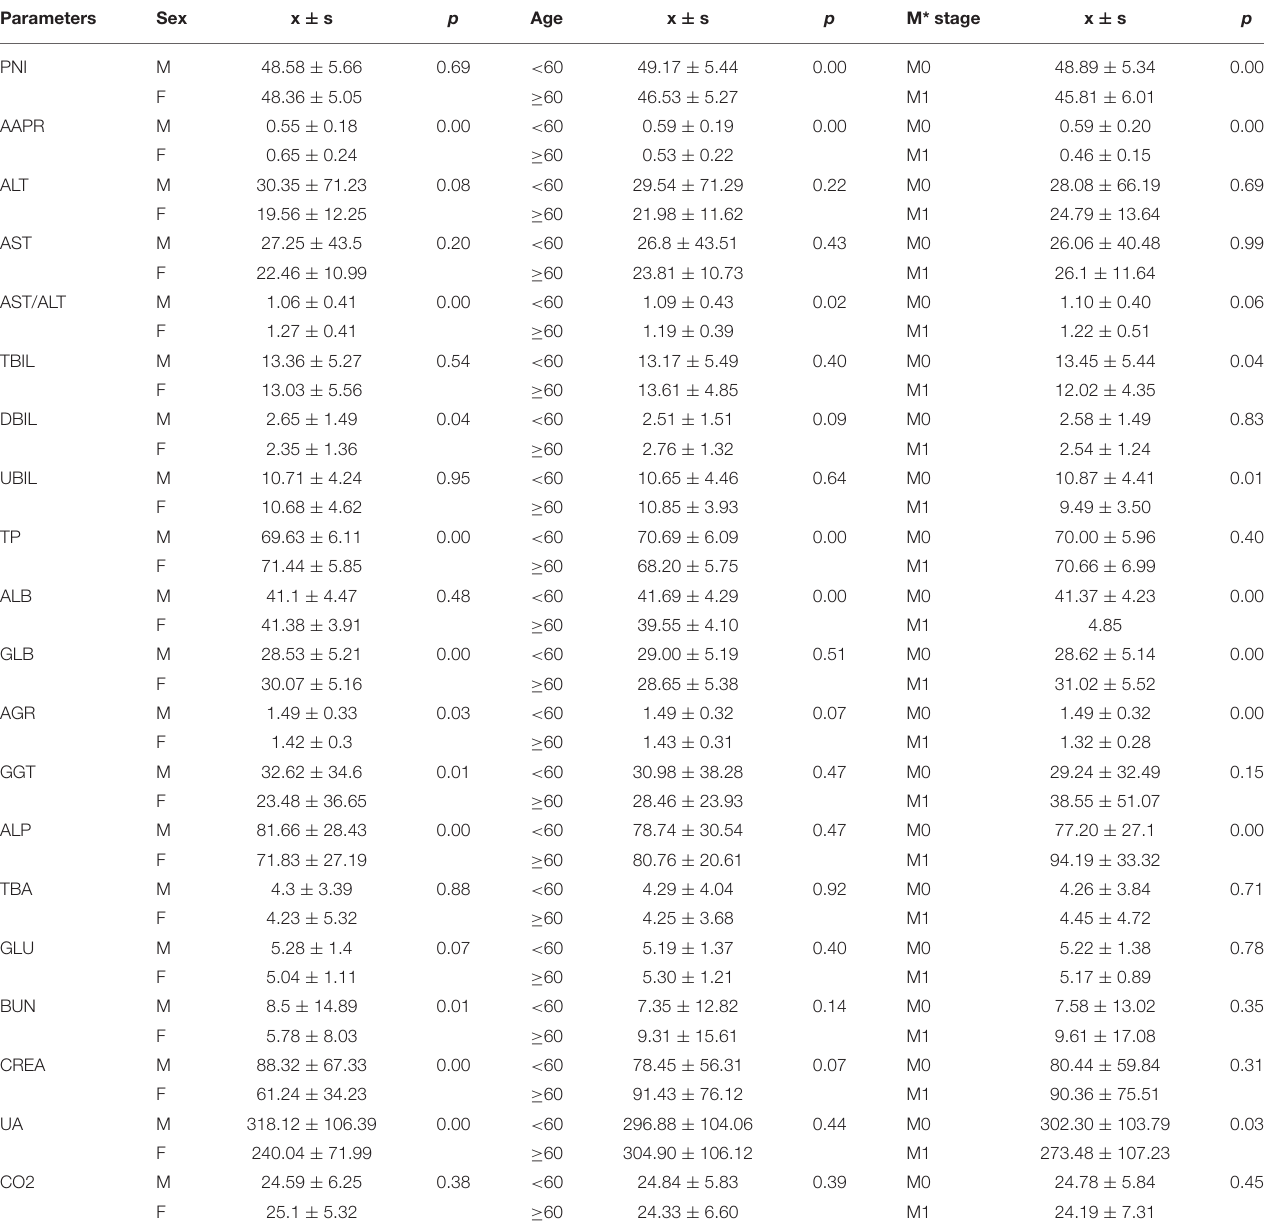
TABLE 1 | General characteristics of serological parameters of 559 included subjects.